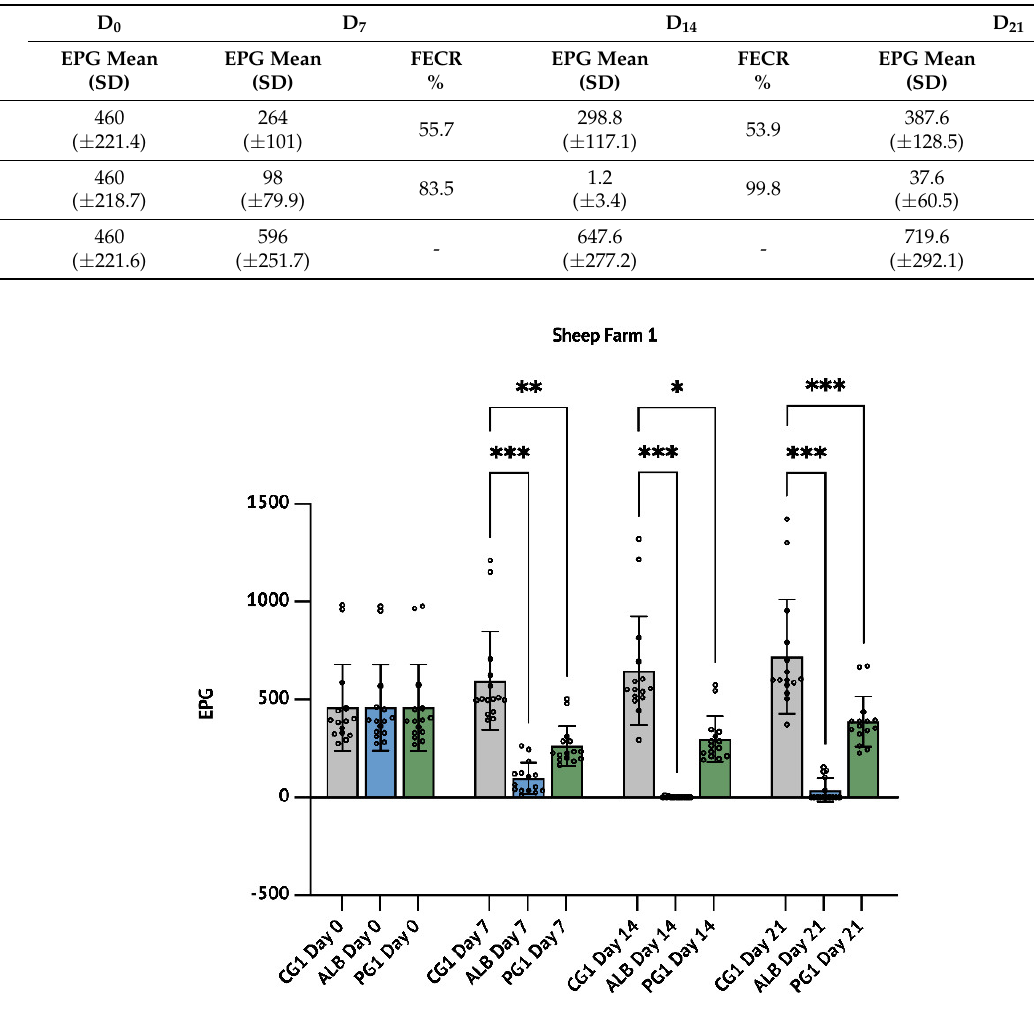
Table 2. Sheep farm 2 (SF2): results concerning the comparison between the anthelmintic efficacy of aqueous P. granatum macerate with Ivermectin. PG2: treated aqueous P. granatum macerate group 2 (50/mL/OS as a single dose); IVM: treated Ivermectin group (200 μg/Kg B/W/SC as a single dose); CG2: untreated control group 2; gastrointestinal nematodes (GINs) eggs per gram (EPG) of faeces (mean) of the different groups and the faecal egg count reduction (FECR) (%) at different days (D) after treatment; SD (standard deviation). SF2 groups